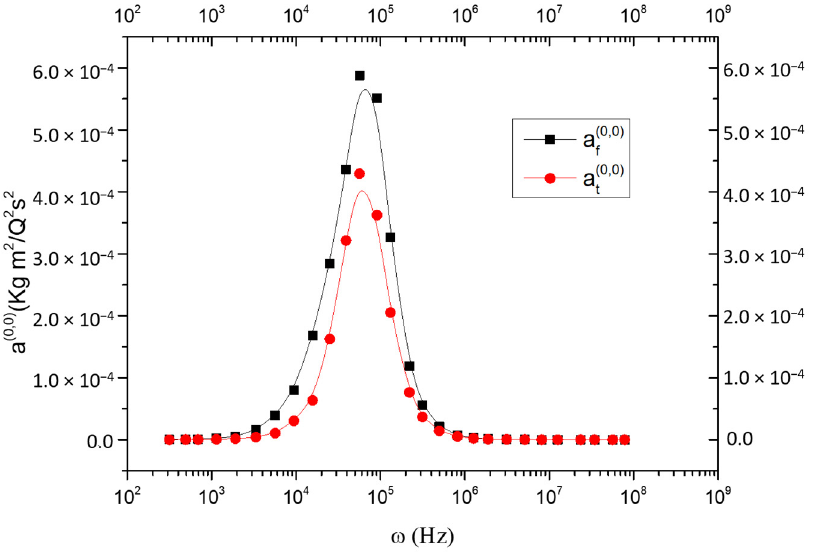
Figure 8. Comparison between normal (black line) and cancerous cells (red line) of state coefficients a (0,0) as a function of frequency, see Equation (A15).